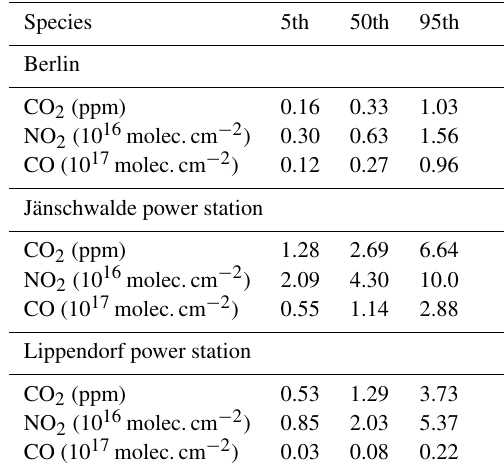
Table 5. The 5th, 50th and 95th percentile of CO 2 , NO 2 and CO signals of Berlin as well as Jänschwalde and Lippendorf power sta-